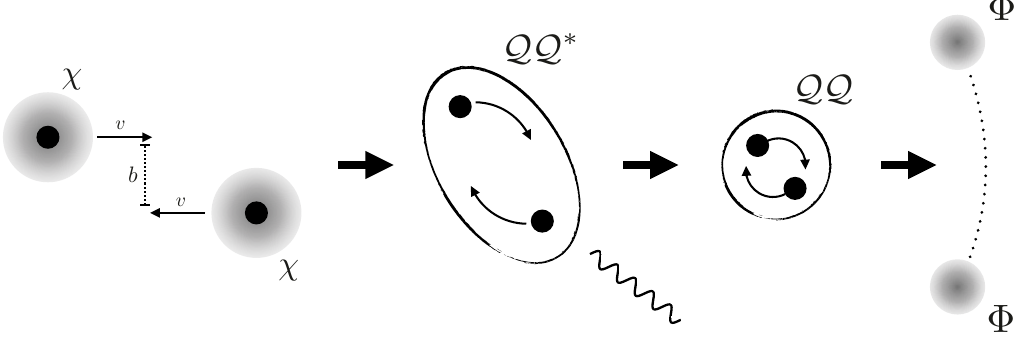
Figure 3 . Cartoon of the re-annihilation processes occurring after dark con(cid:12)nement. First, free quarks combine into color singlets gluequarks. Next, fast collisions form excited at su(cid:14)ciently low temperatures fall into the ground state and